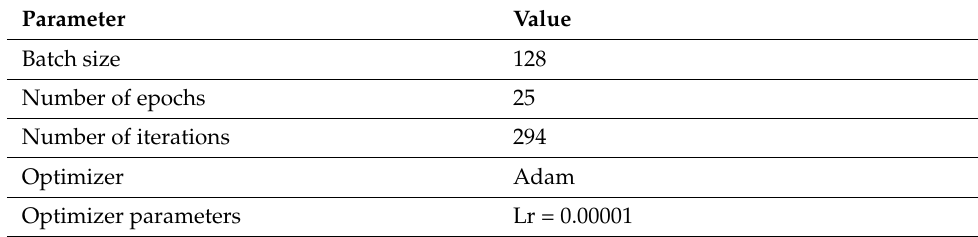
Table 4. Hyper parameters for training the